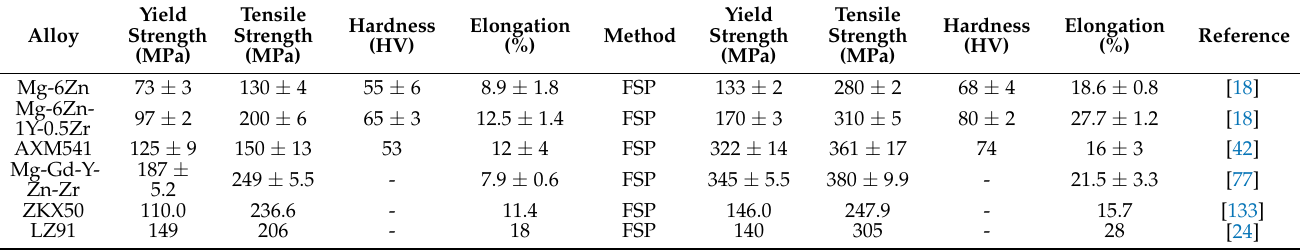
Table 7. The results of Table 7 confirm the improvement of mechanical properties of Mg alloys via FSP. Table 7. Mechanical properties of Mg-based alloys before and after